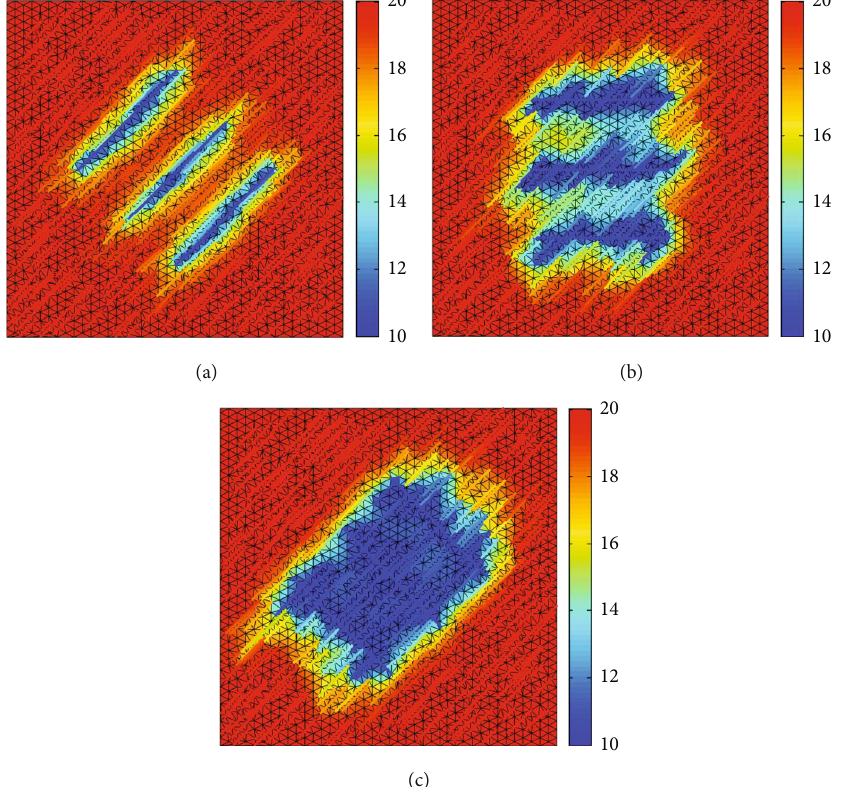
Figure 13: Reservoir pressure pro fi les at t = 200 days: (a) θ = 90 ° ; (b) θ = 45 ° ; (c) θ = 0 ° .